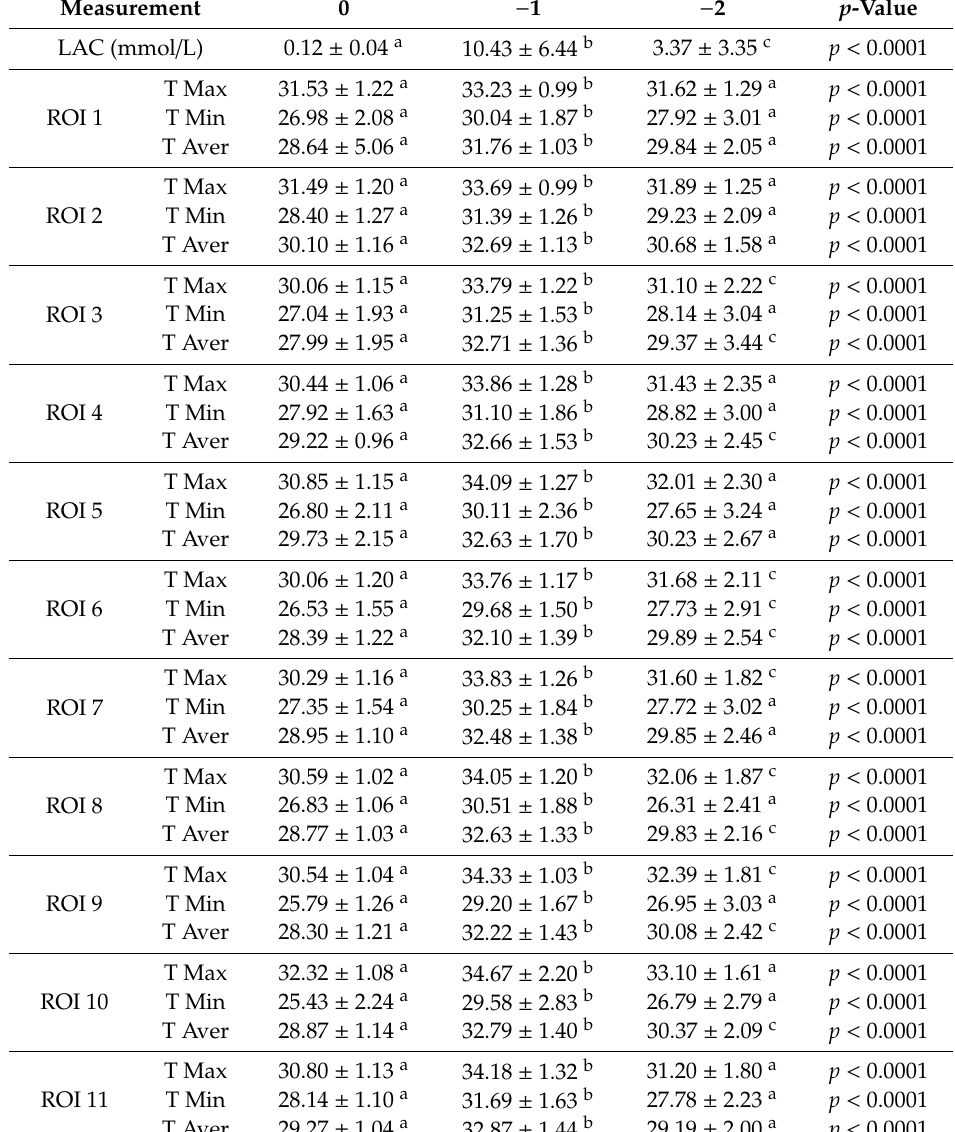
Table 2. The blood lactate concentration and temperature measurements (mean ± SD) in the selected ROIs before training (0, n = 40), immediately after exercise (1, n = 40), and 30 min after exercise (2, n = 40).